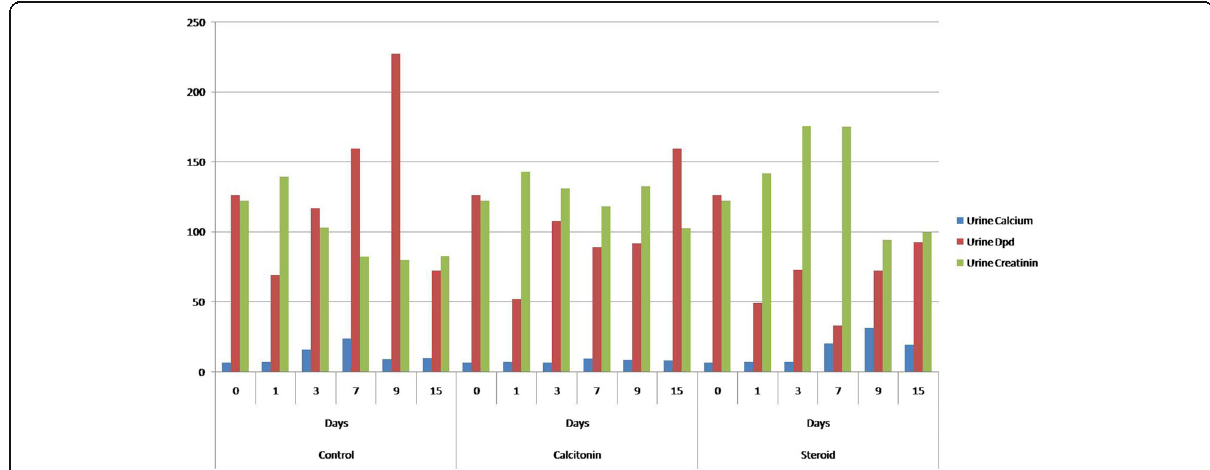
Fig. 5 The boxplot graph of urine analysis for the study groups in regard to specific time